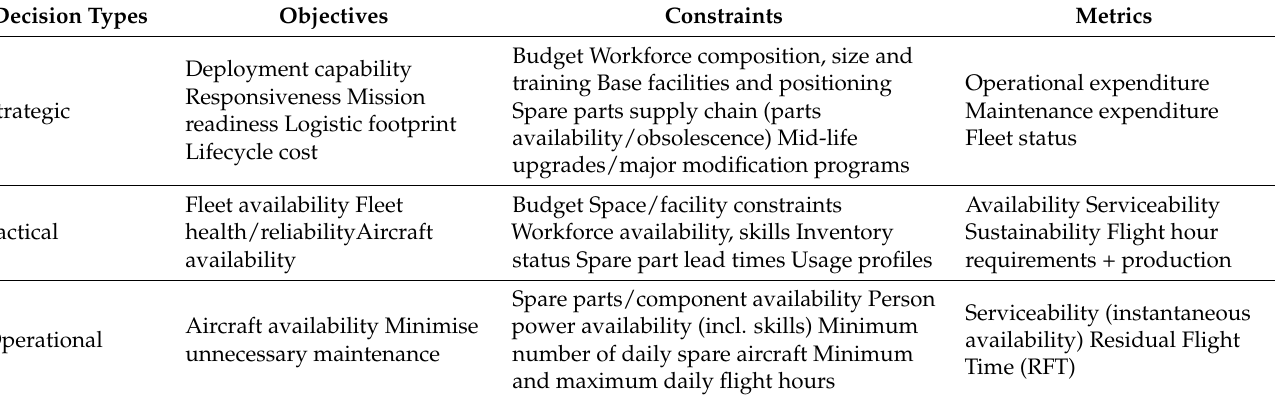
Table 5. Maintenance decision-making objectives, constraints, and metrics for military avia- tion